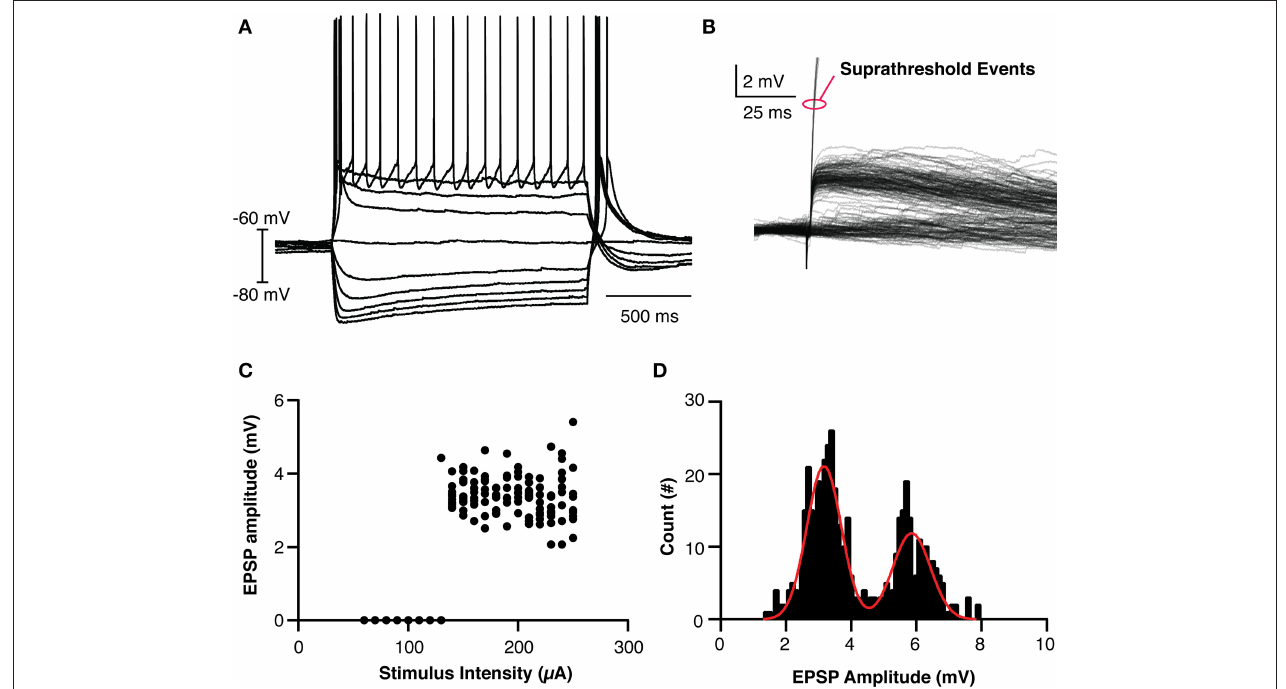
FIGURE 2 | Basic Properties of LGN thalamocortical neurons and their retinogeniculate EPSPs. (A) Overlaid traces showing the response of an LGN cell to current injection. (B) Overlaid traces showing the recruited retinogeniculate EPSPs in response to optic nerve stimulation. Events marked with red oval are truncated spikes. (C) Calculated EPSP size vs. stimulation intensity for the cell shown in (B) , clearly showing the lack of graded recruitment of EPSP amplitude. (D) The histogram of EPSP amplitudes across all cells and events, clearing showing two peaks, where the amplitude of the larger peak is essentially twice the amplitude of the smaller peak. The cell in (C) had events only from the smaller amplitude peak.